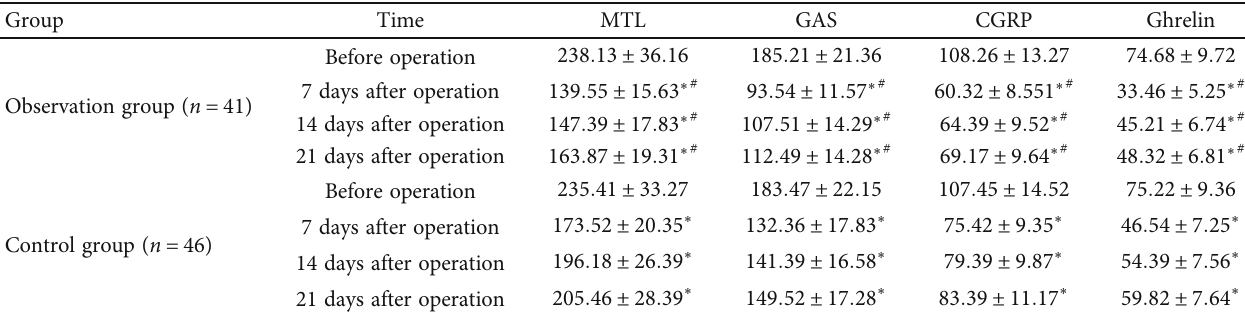
Control group ( n = 46 ) Values are presented as mean ± SD . ∗ P < 0 : 05 vs. before operation; # P < 0 : 05 vs. control group. MTL: Motilin; GAS: Gastrin; CGRP: Calcitonin gene-related peptide; Ghrelin: Growth hormone-releasing peptide. Table 2: Comparison of stress hormone contents at di ff erent postoperative intervals. Group Observation group ( n = 41 )